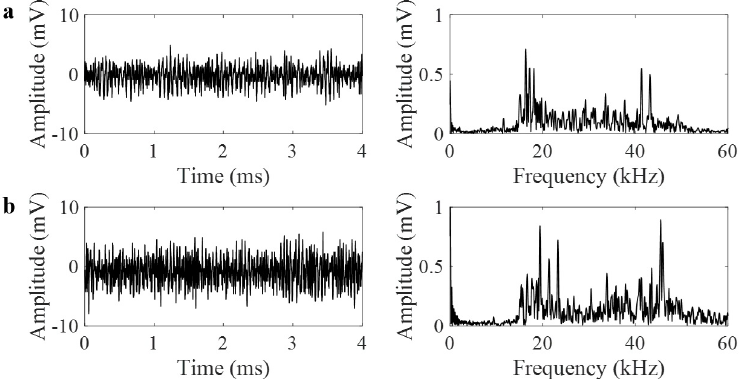
Figure 8. ( a ) Leak waveforms at 10 psi internal pressure in time and frequency domains with lens, ( b ) without lens.